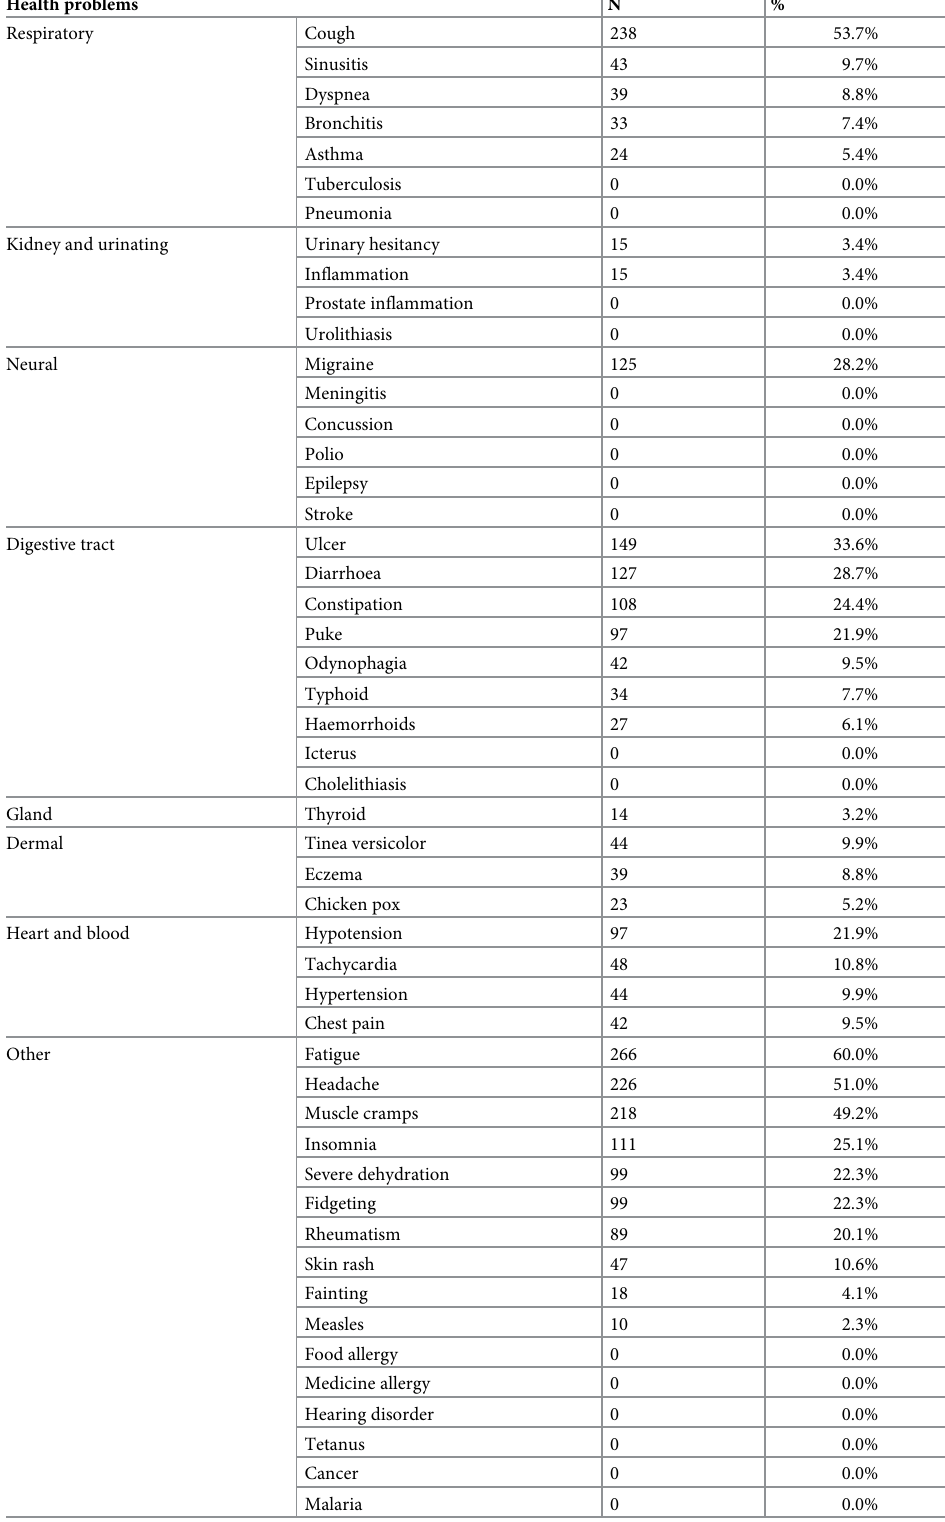
Table 2. A summary table of respondents’ past health problem